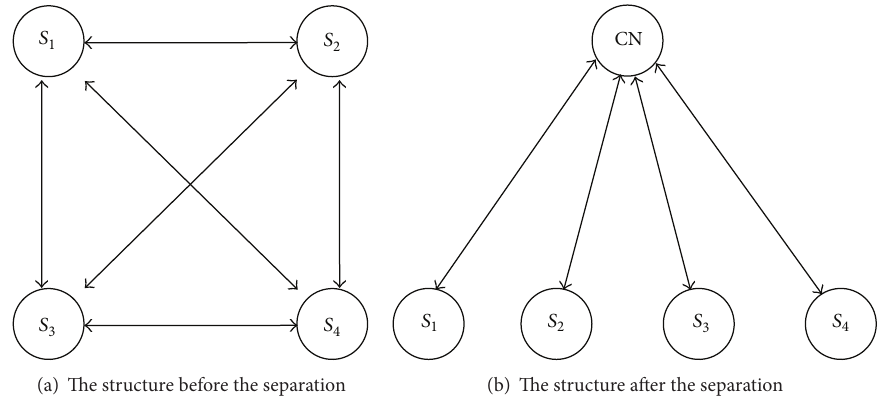
Figure 1: A separation of the common nodes for a web link graph which has four